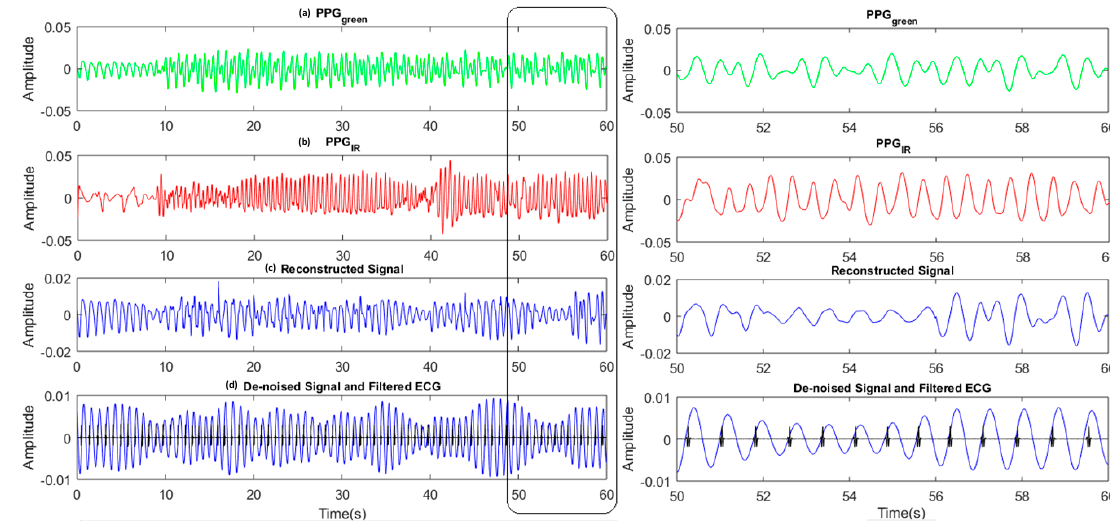
Figure 10. Left: Time domain signals from top: ( a ) Corrupted Green PPG signal and; ( b ) Corrupted IR PPG signal; ( c ) PPG signal after motion removal and reconstruction; ( d ) PPG signal (blue curve) after de-noising together with ECG (black curve). Right: Similar signals as on the right but an enlargement of the signal between 50 and 60 s. Sensors 2019 , 19 , x FOR PEER REVIEW 12 of 18